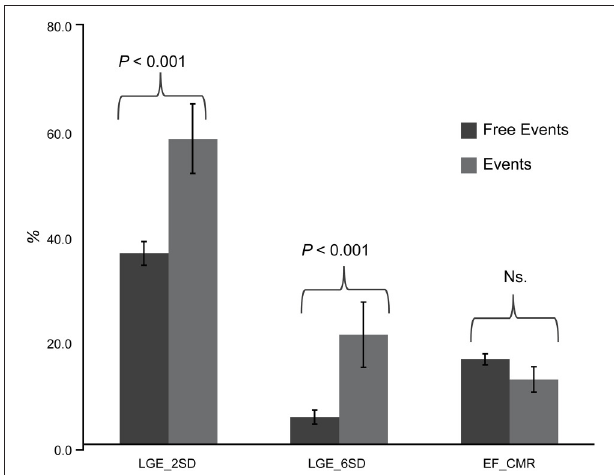
patients with and without events. No statistical difference in conventional cardiac ejection function index (mean ± SE, P = 0.16) is detected. LGE, late